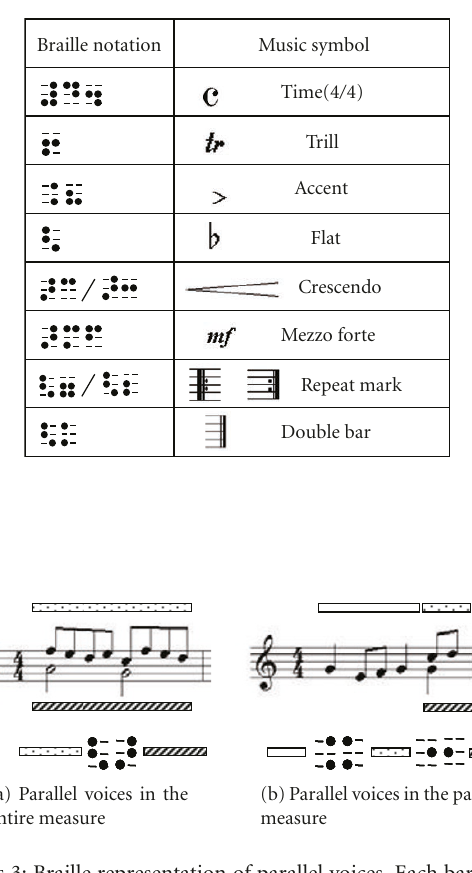
Table 2: Some of Braille signs for music symbols.